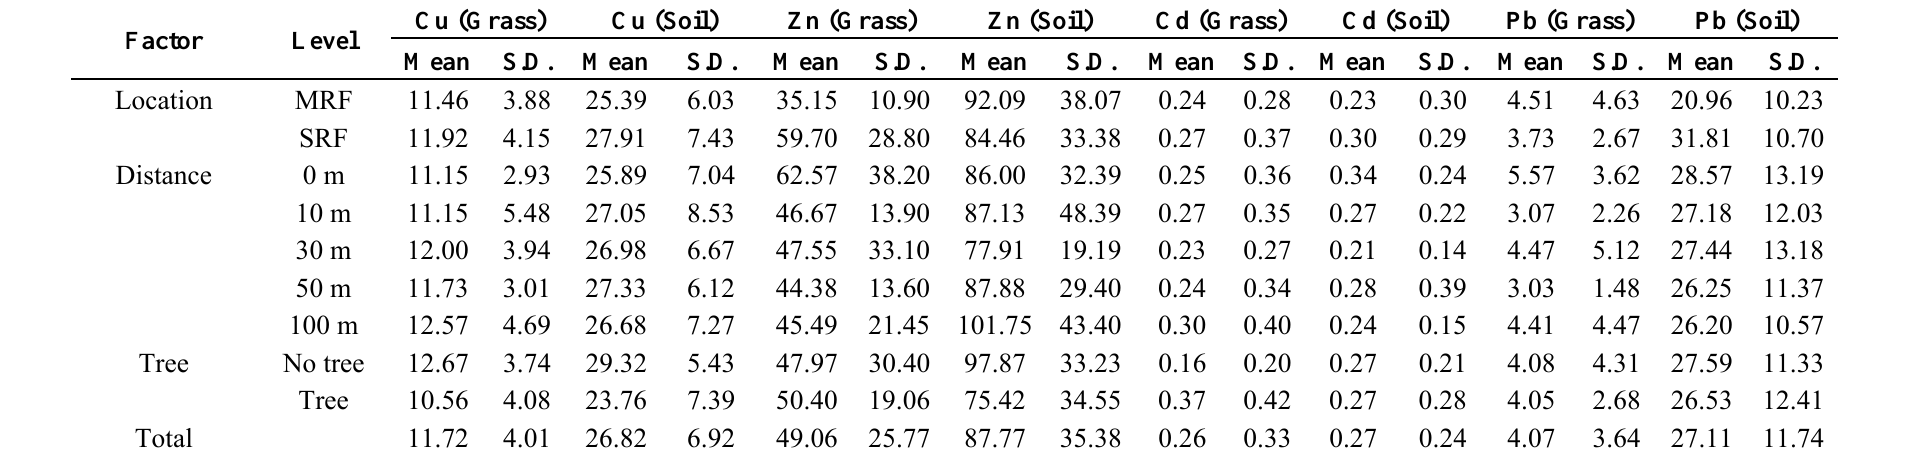
Table 3. Descriptive statistical results of heavy-metal concentrations (mg/kg) in soil and